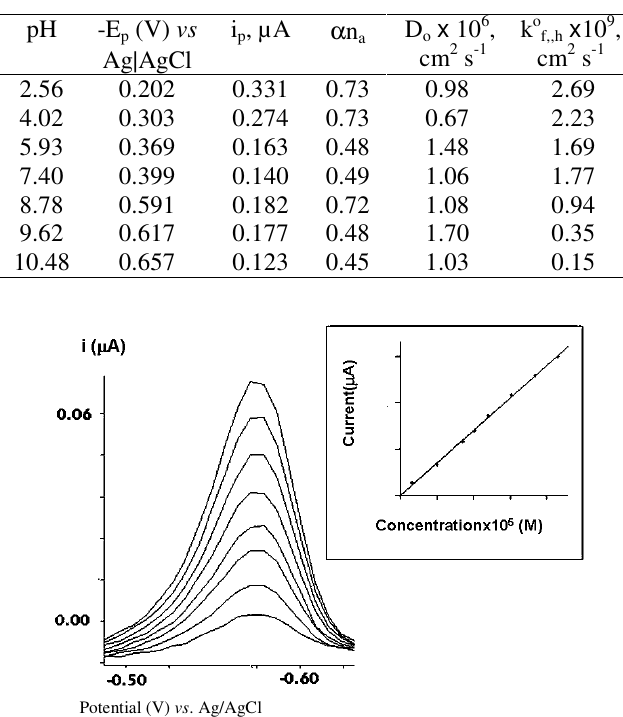
Table 2. Voltammetric data of 1.